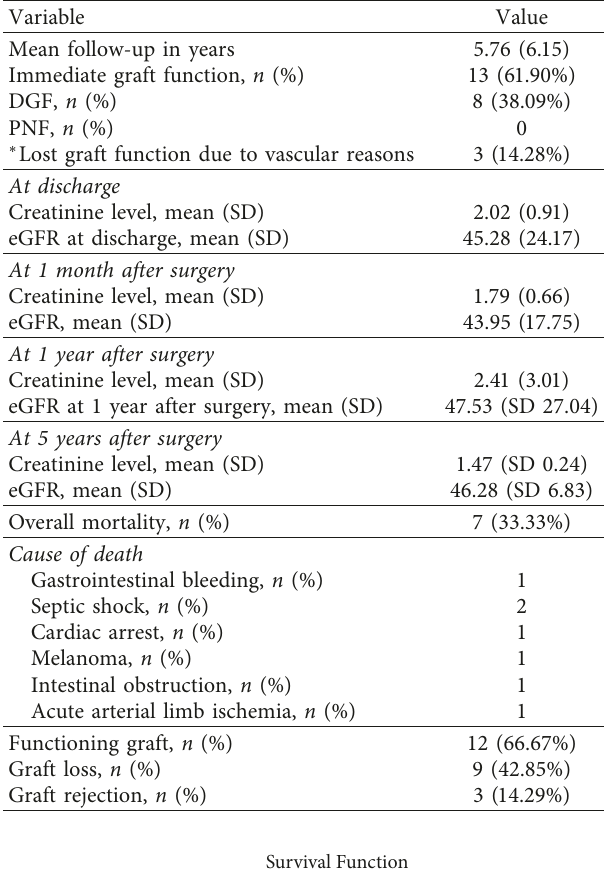
Table 6: Baseline characteristics of the KAT series.